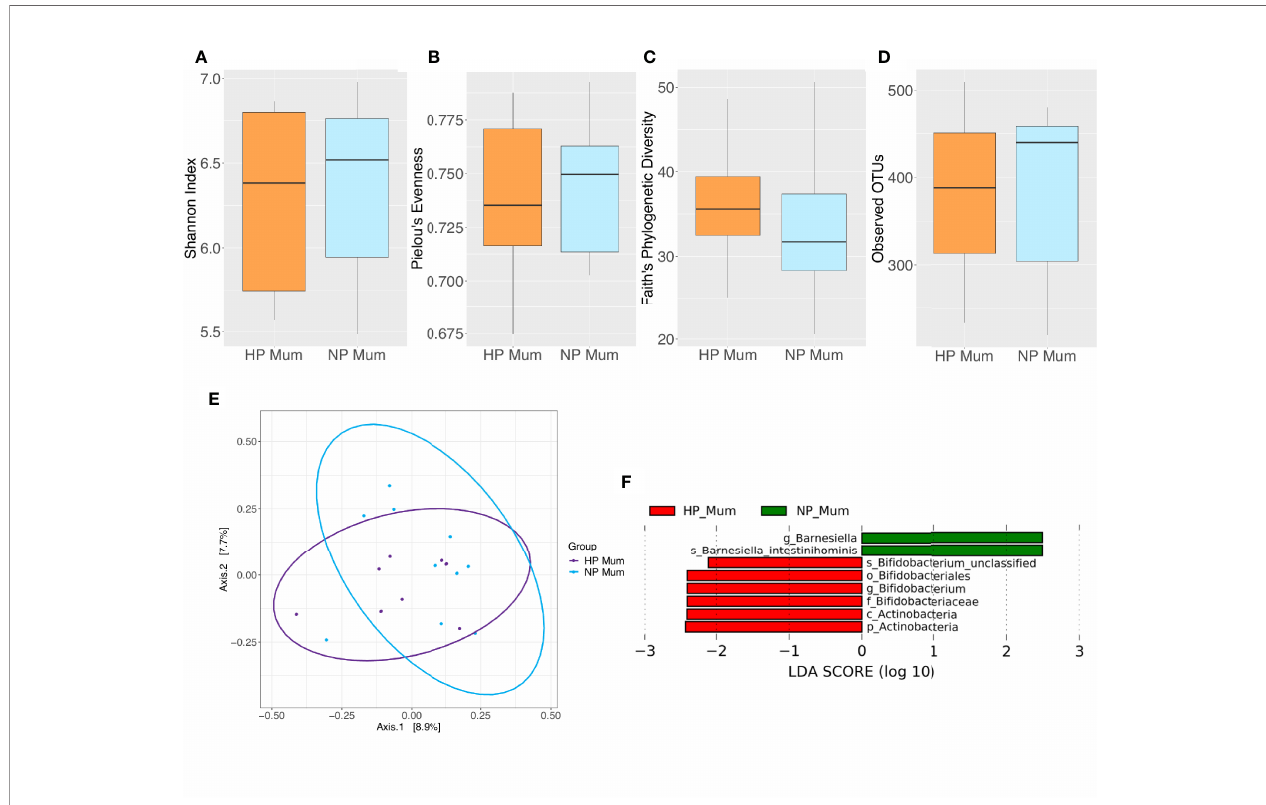
FIGURE 3 | Comparison of microbiota composition and diversity between hypertensive pregnancy (HP) mothers ( n = 8) and normotensive pregnancy (NP) mothers ( n = 10) based on faecal samples. Alpha diversity measured by (A) Shannon index (B) Pielou ’ s evenness (C) Faith ’ s phylogenetic diversity (D) Observed operational taxonomic units (OTUs). Boxes represent the interquartile range (IQR), the line inside the box indicates the median and whiskers represent values 1.5 × IQR from the fi rst and third quartiles respectively. Differences between groups were tested using the Wilcoxon sum rank test and false discovery rate (FDR) corrected. Overall, no signi fi cant differences were observed in alpha diversity between HP and NP groups. (E) Principal Coordinates Analysis (PCoA) of microbiota community structure in HP and NP mothers. The points represent individual samples from mothers and the ellipse illustrates the 95% con fi dence intervals of multivariate normal distribution. (F) Differentially abundant bacterial taxa as identi fi ed by Linear discriminant analysis Effect Size (LEfSe). Bacterial taxa were classi fi ed as differentially abundant if their P value was < 0.05 and their linear discriminant analysis (LDA) log score was > 2. Taxa enriched in HP mothers are indicated by red, and taxa enriched in NP mothers are indicated by green. Taxon levels are abbreviated with p_ = phylum, c_ = class, o_ = order, f_ = family, g_ = genus and s_ = species. LDA effects sizes and signi fi cant P values are in detailed in Supplementary Table 5